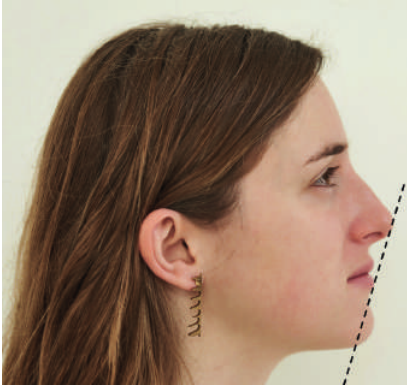
Figure 4. Nasomental line- the nasomental line connects the nasal tip to the lips and then the chin. The chin should deviate no more than 4mm either side of the nasomental line to be considered